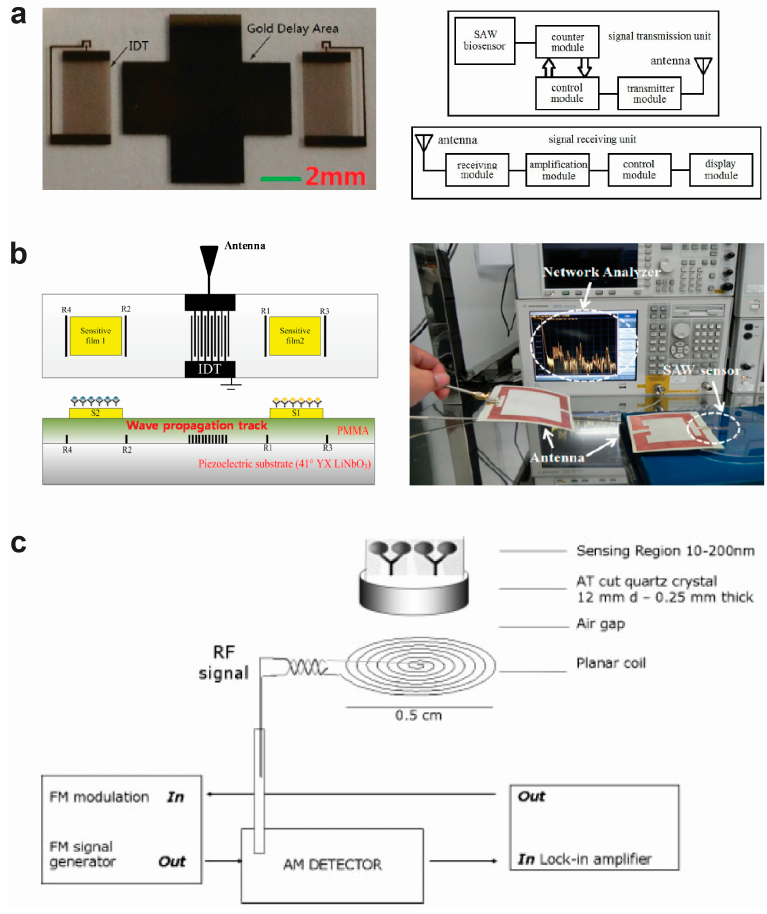
Figure 2. Wireless acoustic-based bioelectronic sensors. ( a ) Two-port SAW-based biosensor with antenna. Reprinted with permission from [64]. Copyright (2014) Worldscientific. ( b ) One-port SAW-based biosensor with antenna [65]. ( c ) Magnetic acoustic resonance biosensor. Reprinted with permission from [42]. Copyright (2006) Wiley.